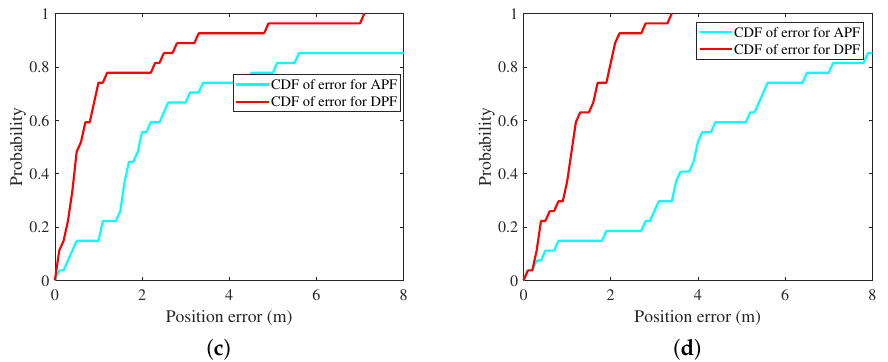
Figure 11. CDFs of errors with different modes. ( a ) CDFs of errors with calling mode. ( b ) CDFs of errors with dangling mode. ( c ) CDFs of errors with handheld mode. ( d ) CDFs of errors with pocketed